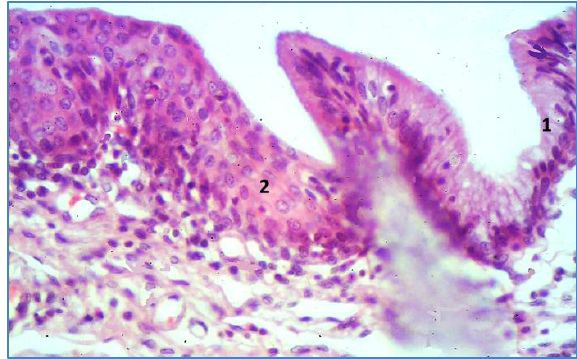
Figure, 9: epithelium of proctodeum (hen turkey) shows: simple columnar epithelial (1) and stratified squamous epithelial (2) (H and E) satin.